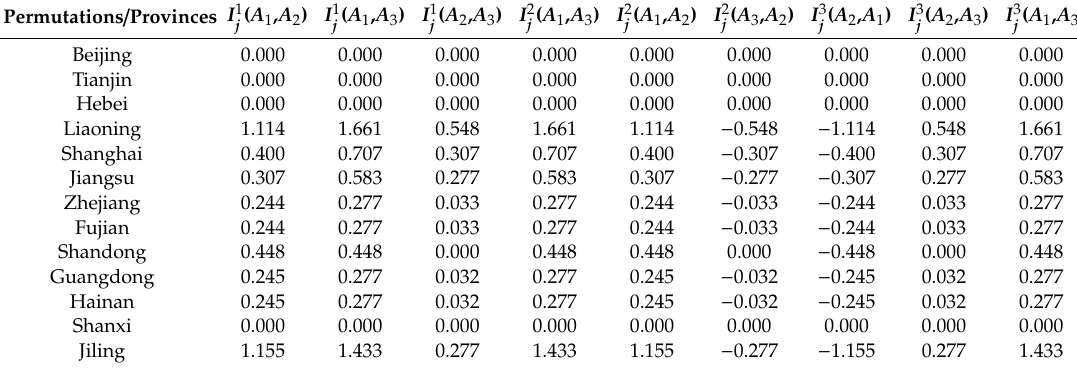
(cid:16) (cid:17) A ρ , A β j